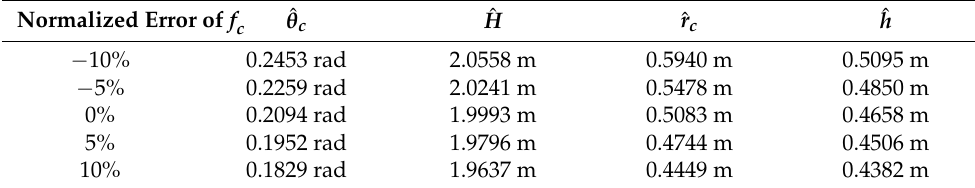
Table 4. The estimated values of the other four parameters with different normalized error of coning